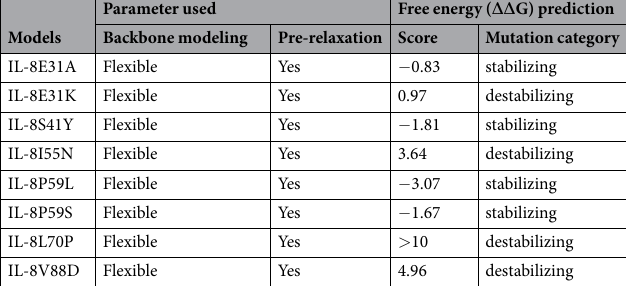
Table 4. Physical-principal based prediction of ∆∆ G using Eris server